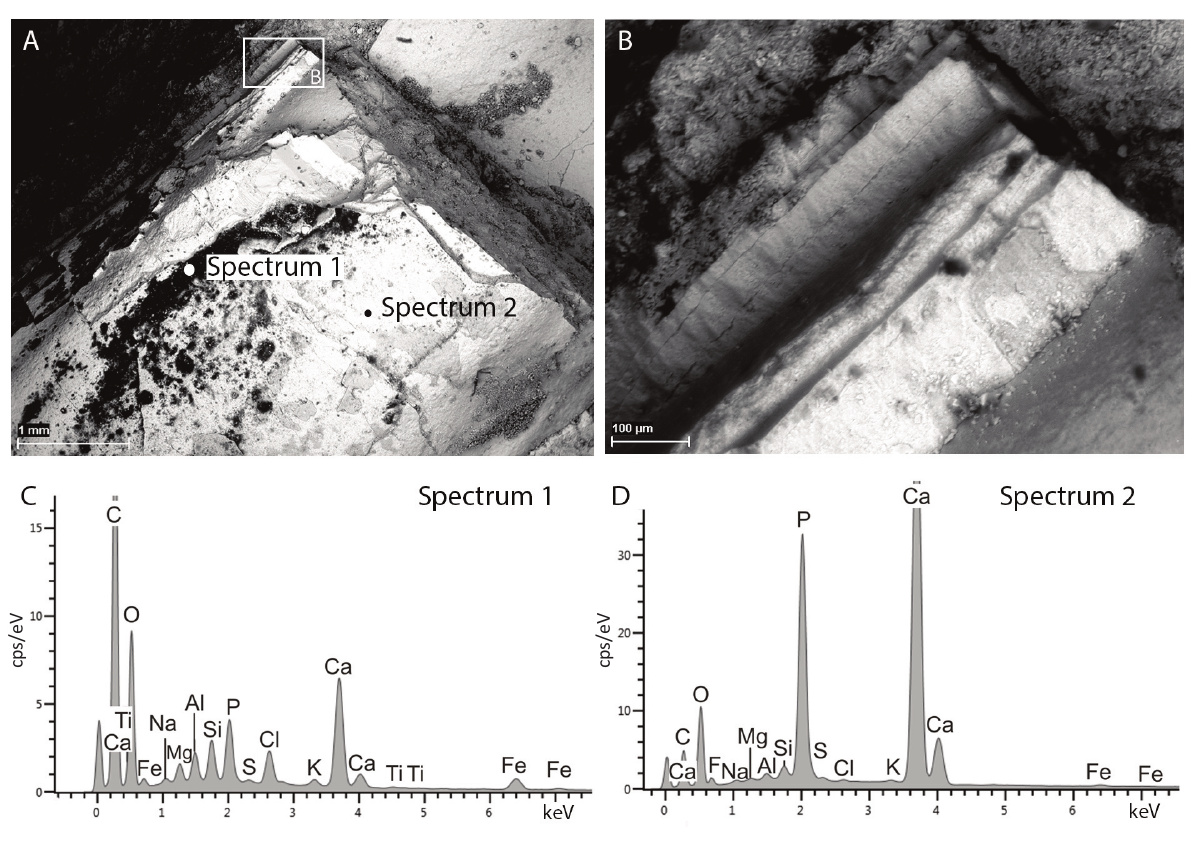
Fig. 5. Microstructure ( A , B ) and EDS spectra ( C , D ) of the Martsaphyton moxi gen. et sp. nov. phosphatic tube with patches of carbonaceous